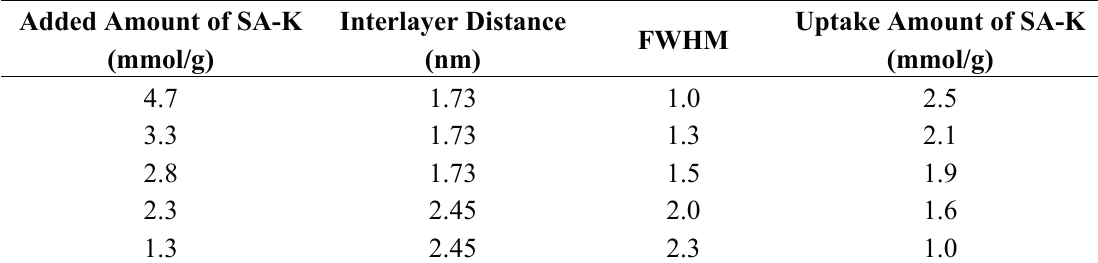
) synthesized in aqueous 3 ) for 5 min at room 3